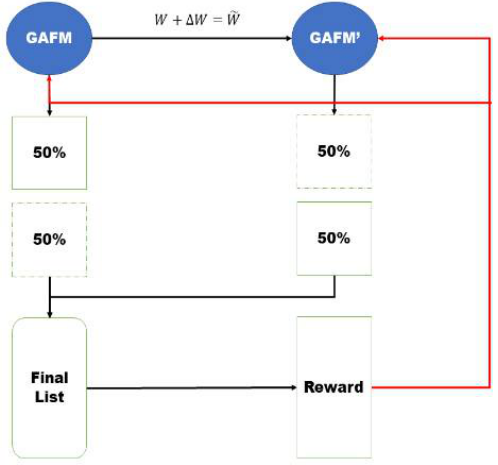
Figure 6. DRFM exploration strategy basic flow.